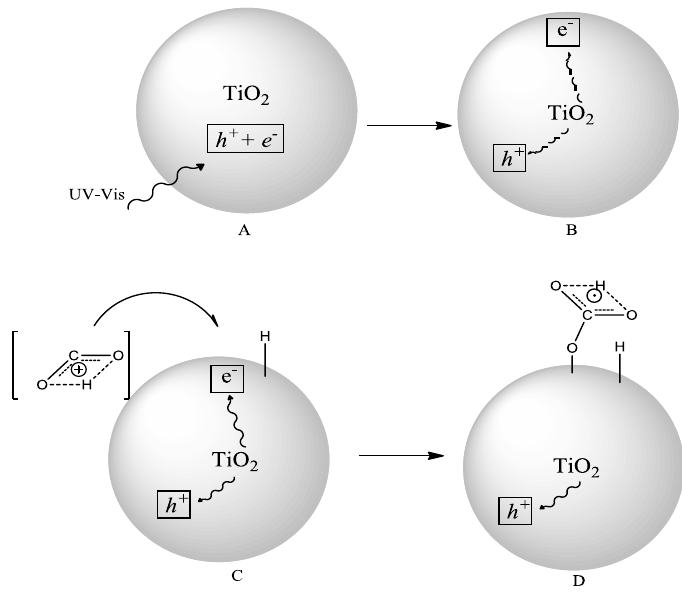
Figure 7. Hypothesized mechanism for the formation of HCOOH on the surface of TiO 2